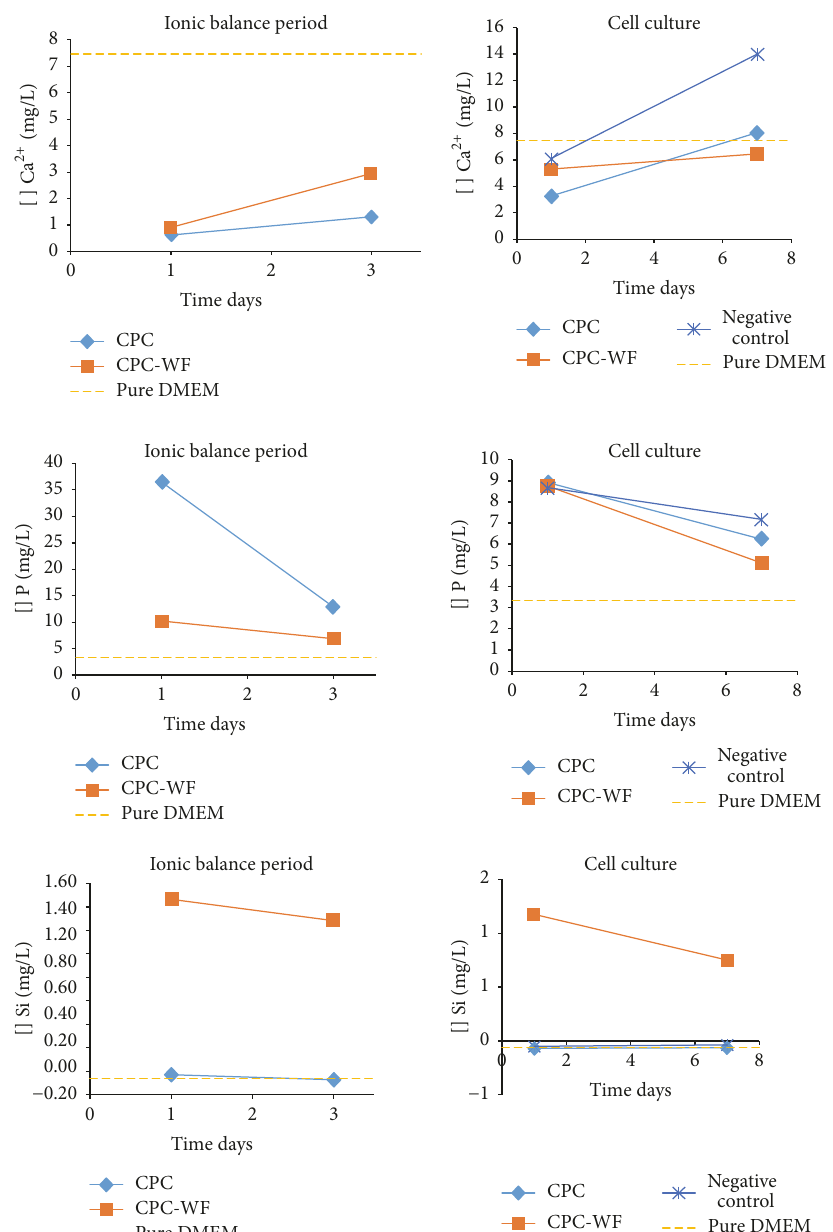
Figure 4: Ca 2+ , Si, and P ion concentrations in culture medium during the 3-day ionic balance period (quantifications at days 1 and 3) and under cell culture (days 1 and 7). DMEM alone was used as a